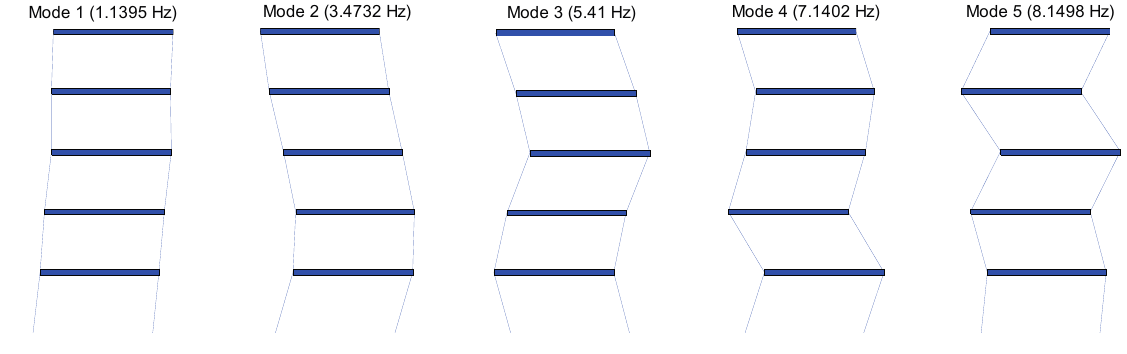
Figure 8. Identified natural frequencies and corresponding mode